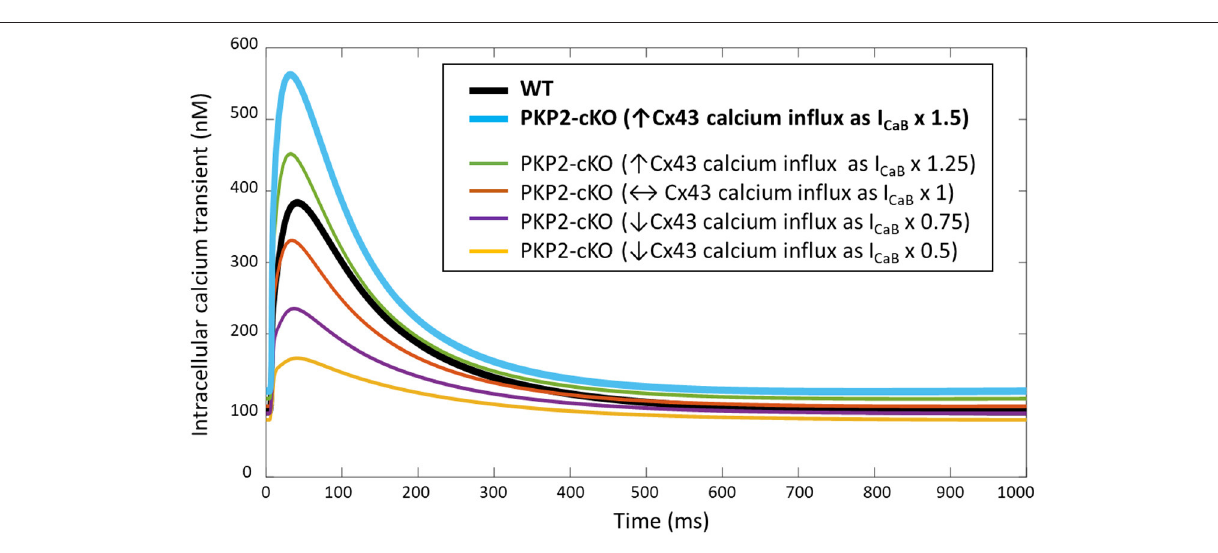
13.1% ( n = 8) of PKP2-cKO models without Cx43 calcium influx. Under BARS, 11.4% ( n = 7) of controls and 16.4% ( n = 10) of the PKP2-cKO models without Cx43 calcium influx showed